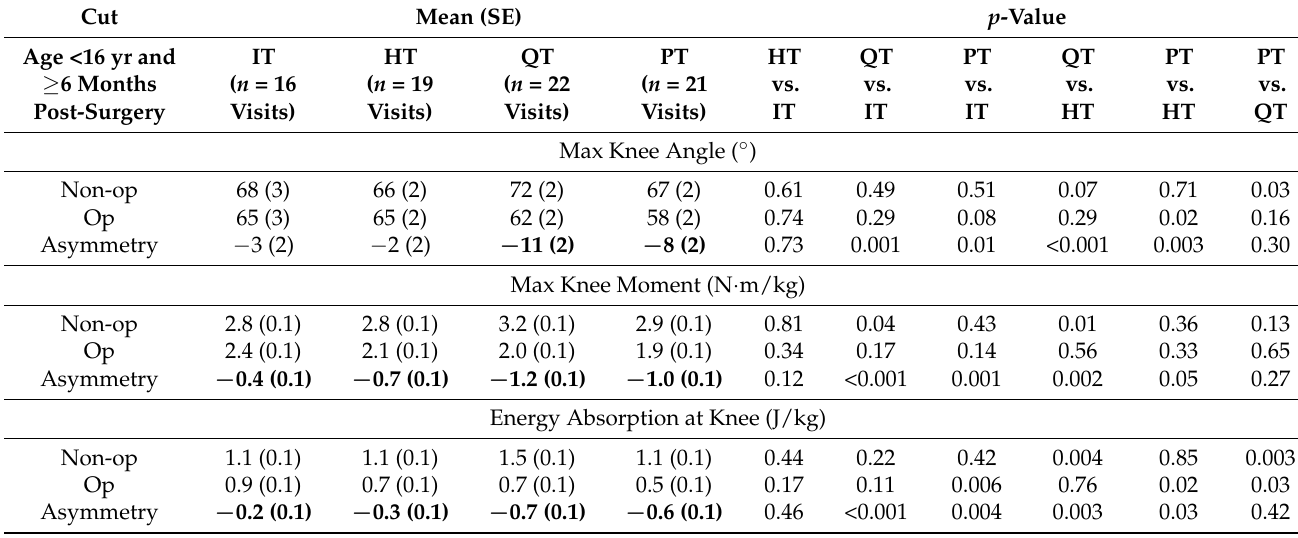
Table A6. Comparison of sagittal knee kinematics/kinetics for operative and non-operative limbs during cutting for patients under 16 years of age and visits at least 6 months